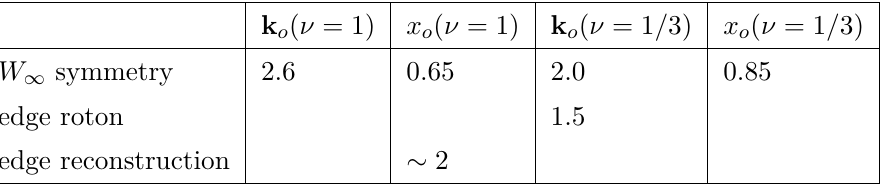
Table 1 . Minimum k o of energy spectrum and positions x o obtained in our analysis versus results for edge reconstruction [30, 31] and edge roton [32] (in units ‘ = 1 ). ditions (4.22) are unchanged, only the unit of length is redefined. From the analysis of section 3.4, we know that the correct scaling is given by r 2 → r 2 /